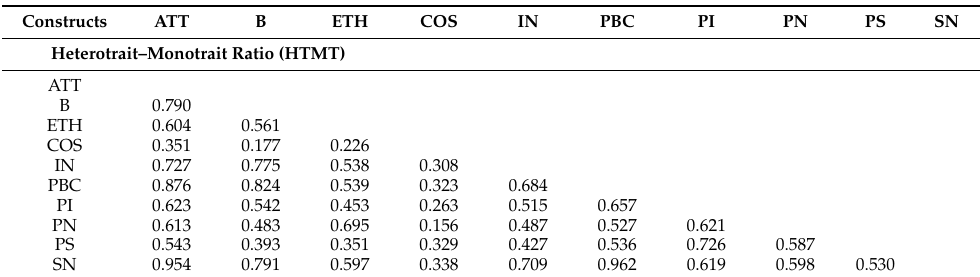
Table 3. Discriminant